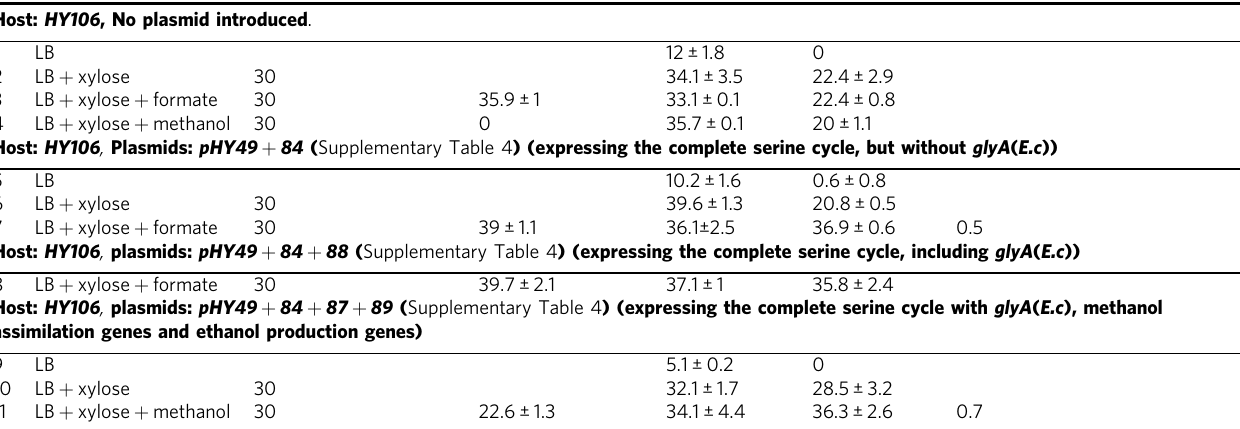
Table 1 Construction of the modi fi ed serine cycle in E. coli improved the production of C2 compounds by co-assimilation of C1 compound with